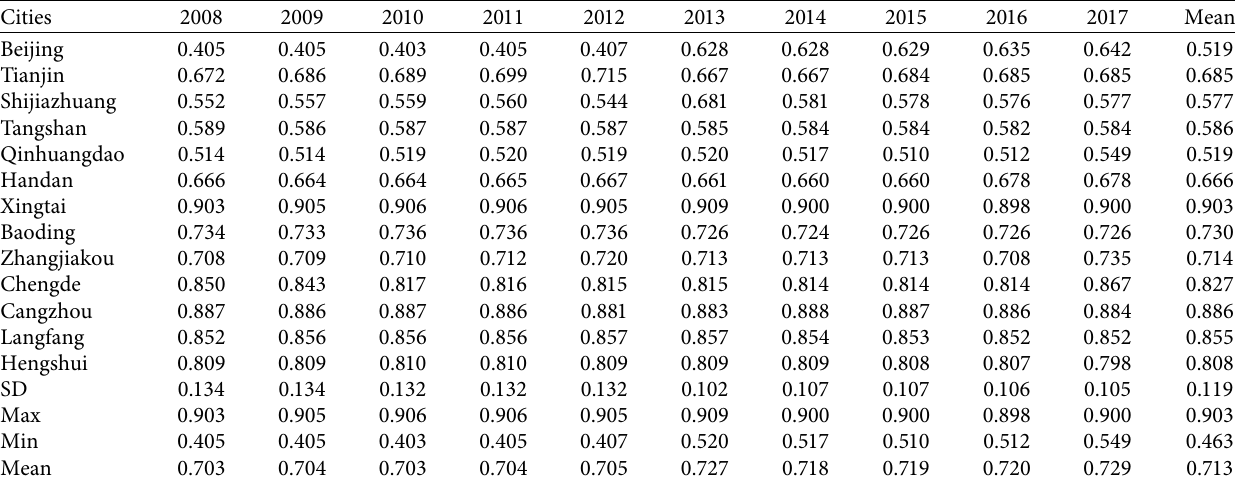
Table 3: Results of dispersion degree of Beijing-Tianjin-Hebei Metropolitan